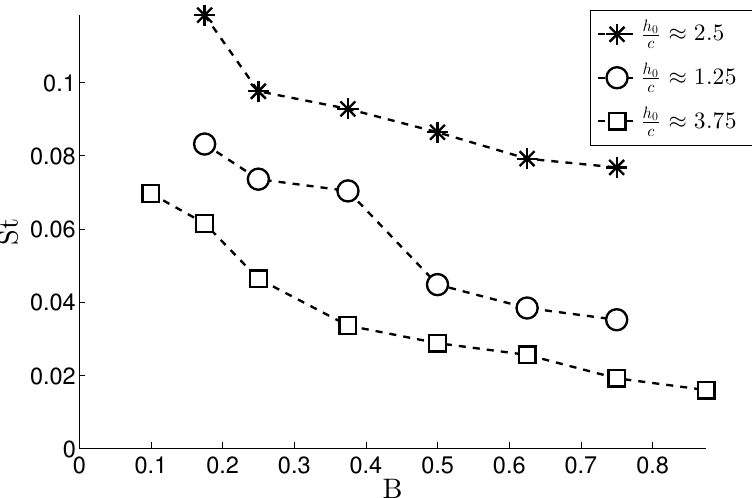
Figure 8. Re = 2 × 10 4 : St vs. B for different values of h 0